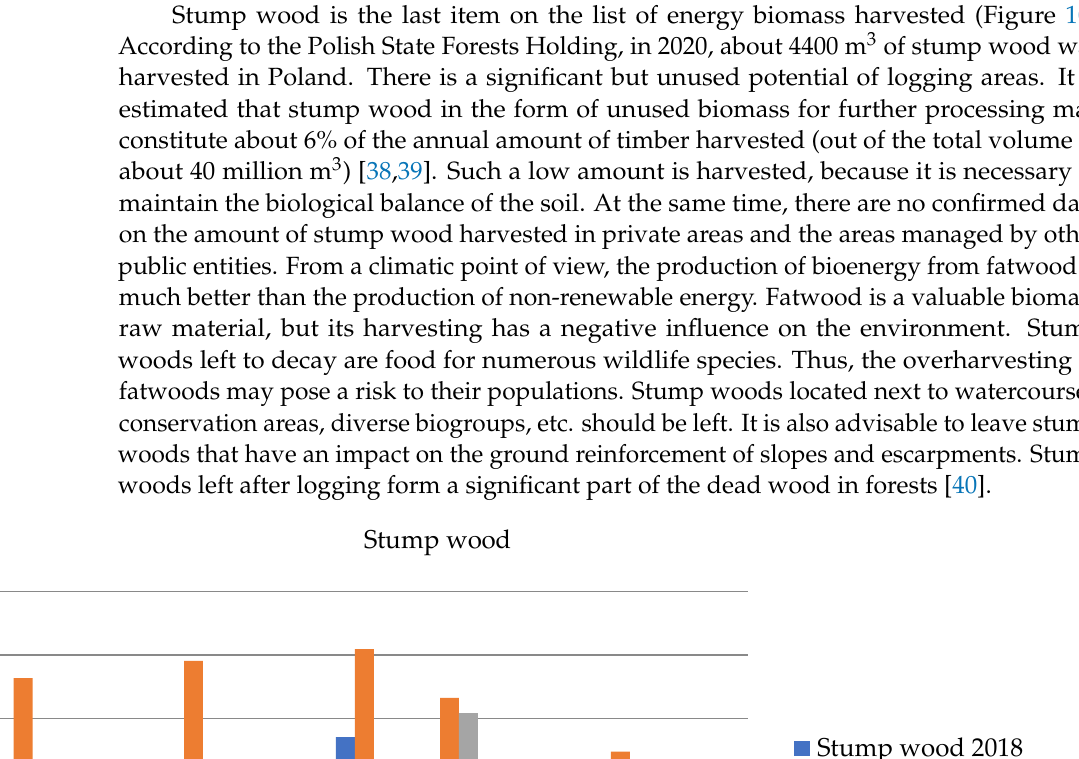
Figure 9. The amount of S4 firewood harvested in Poland between 2018 and 2020. Own elaboration based on the available data.